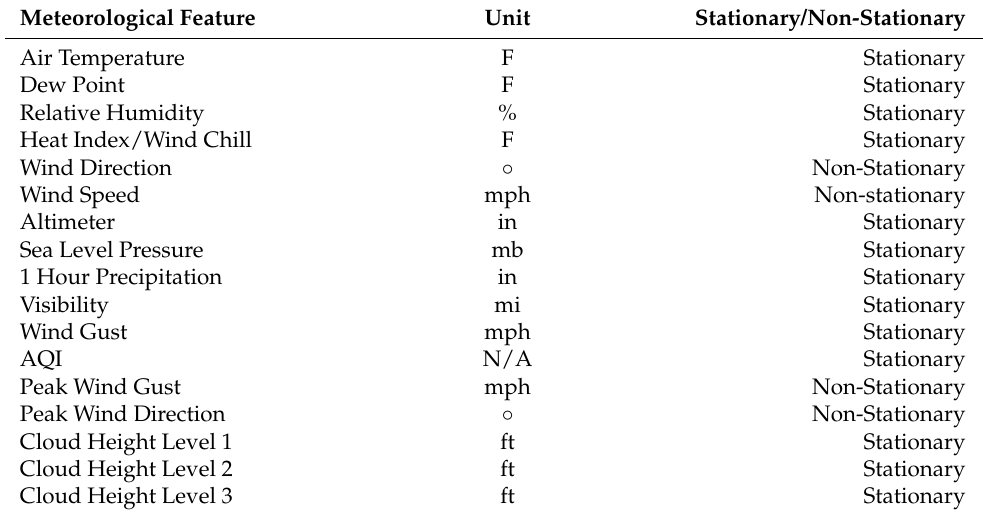
Table A2. METAR Meteorological Features for each of the 24 ASOS sites within Los Angeles county collected from